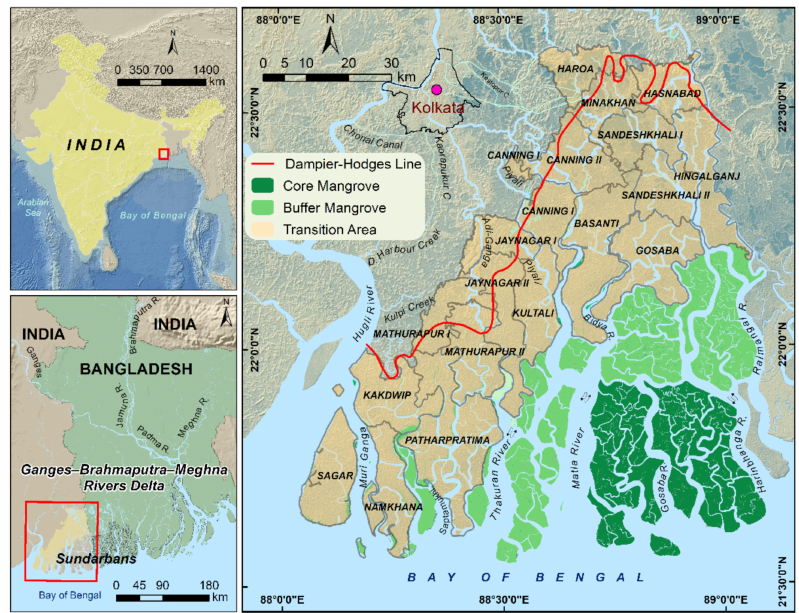
Figure 1. Location of the Sundarbans, including the Indian Sundarbans in the western part of the Ganges–Brahmaputra delta. The Dampier–Hodges line represents the extent of the mangrove forest as mapped in 1830. The core, buffer, and transition areas within the Sundarbans Biosphere Reserve are